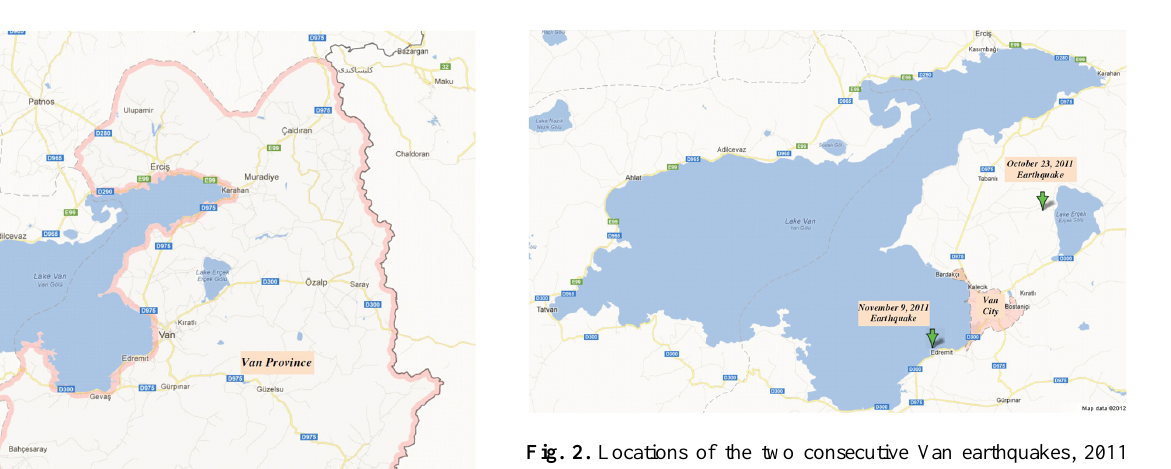
Fig. 2. Locations of the two consecutive Van earthquakes, 2011 (USGS,